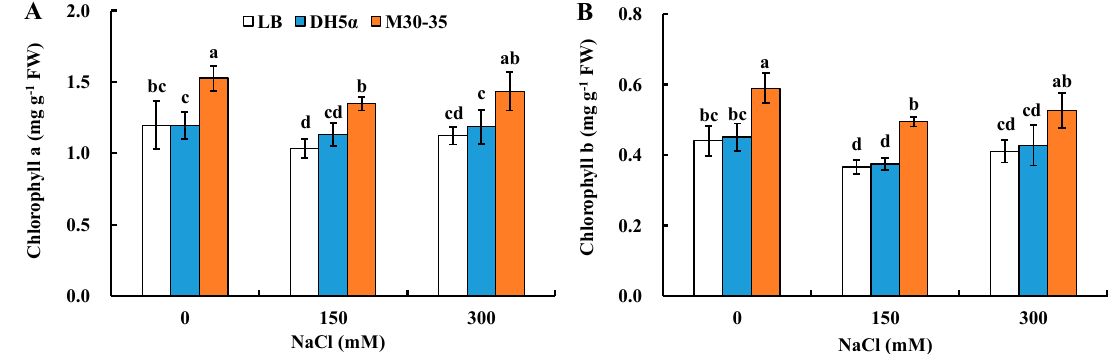
Figure 2. Effects of M30-35 on leaf chlorophyll a content ( A ) and leaf chlorophyll b content ( B ) of ryegrass under various salt stress (0, 150 and 300 mM NaCl). Values are means and bars indicate SEs ( n = 12). Columns with different letters indicate significant differences among treatments at p < 0.05 (ANOVA and Duncan’s post hoc multiple comparison test).